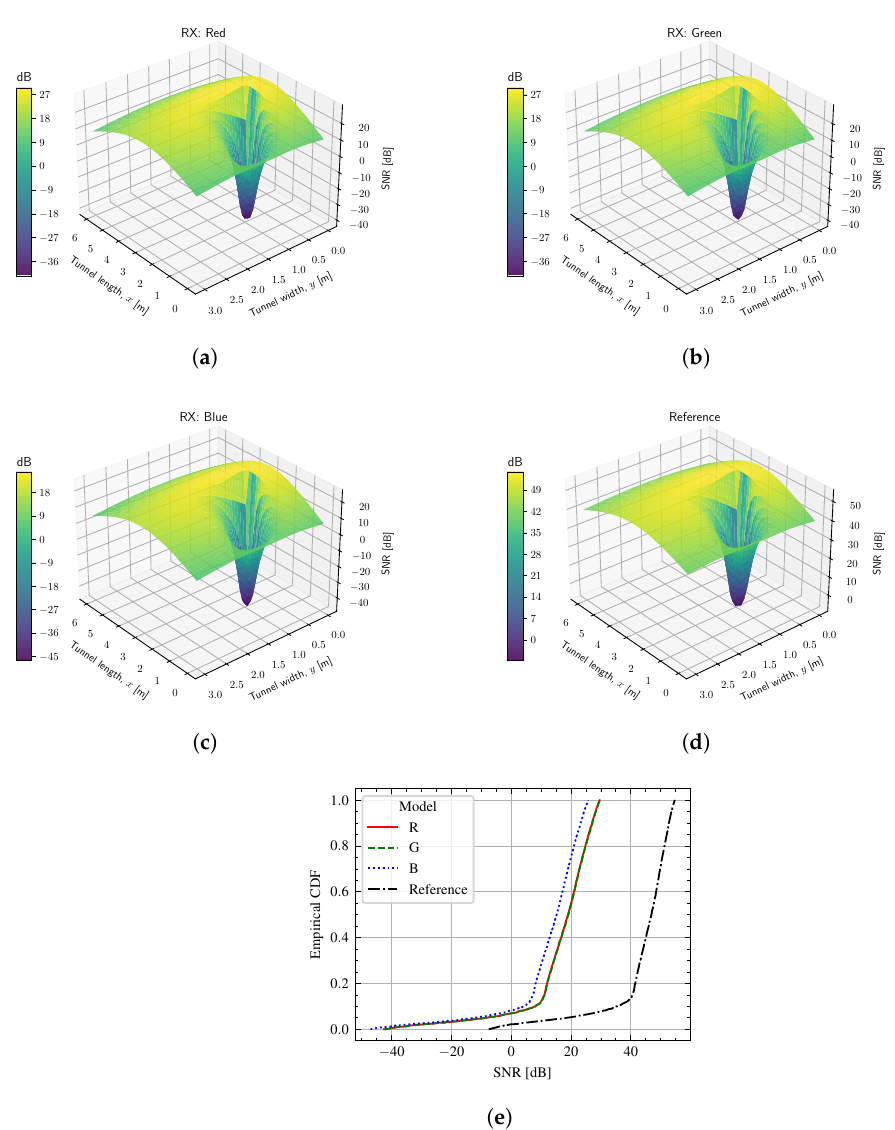
Figure 7. Signal-to-noise ratio. ( a ) Red PD. ( b ) Green PD. ( c ) Blue PD. ( d ) Reference model. ( e ) Empiri- cal CDF for SNR at red, green, and blue PD in the proposed model, and for SNR in the reference